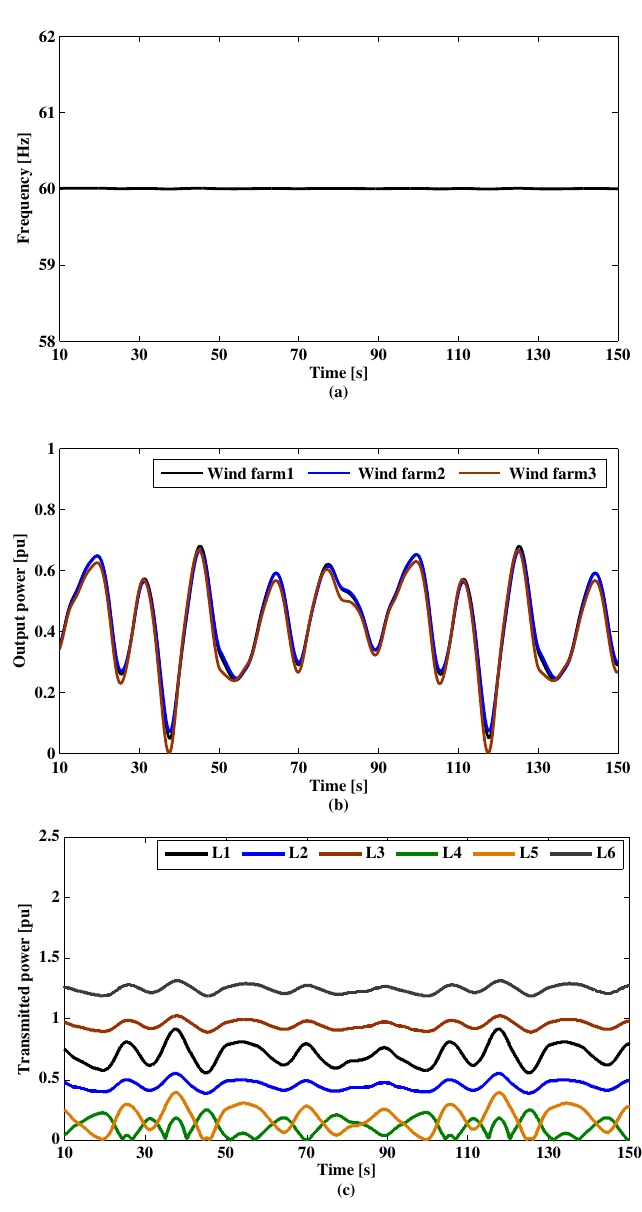
Figure 11. Case 2 result. ( a ) System frequency. ( b ) Generated output power of wind farms. ( c ) Transmitted